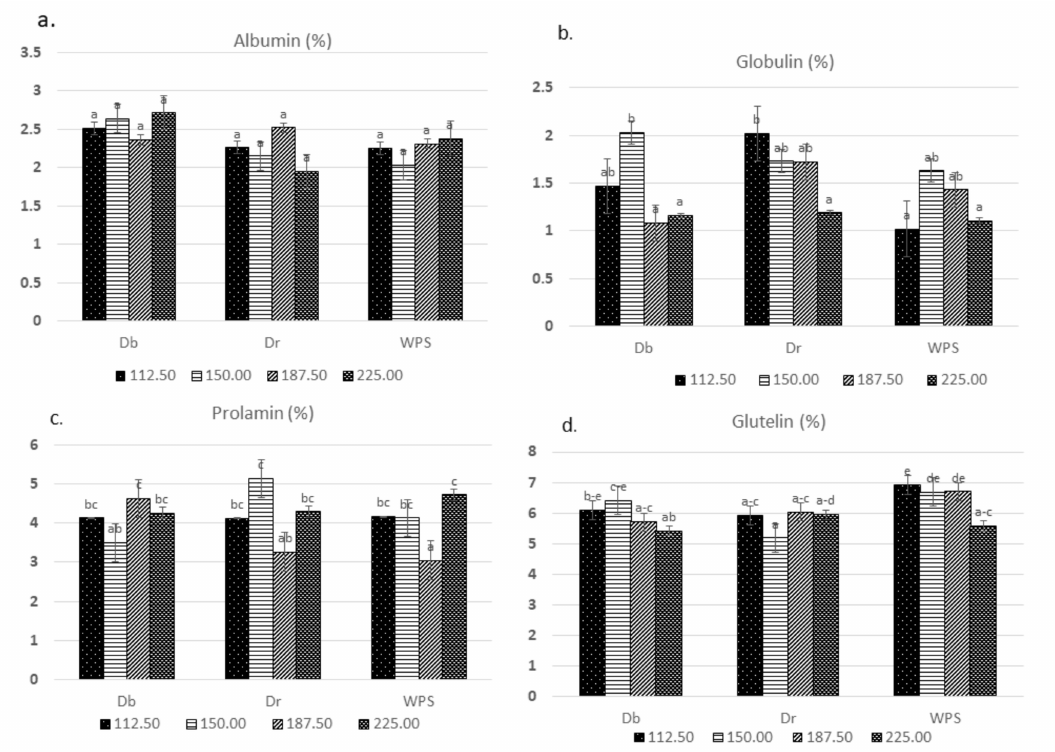
Figure 6. The e ff ects of the sowing methods and seed rate on protein fractions in the second cropping season. ( a – d ) letters represent albumin (%), globulin (%), prolamin (%), and glutelin (%) respectively. Db, Dr, and Wps represent the sowing methods dibbling, drilling, and wide precise sowing, respectively. In summary, 112.5, 150, 187.5, and 225 represent the winter wheat (Xinong805) sown at 112.5 kg ha − 1 , 150 kg ha − 1 , 187.5 kg ha − 1 , and 225 kg ha − 1 , respectively. The vertical bars represent the standard errors ( n = 3); in the same protein fraction, the same letters above the bars indicate no significant di ff erences between the di ff erent treatments ( p <